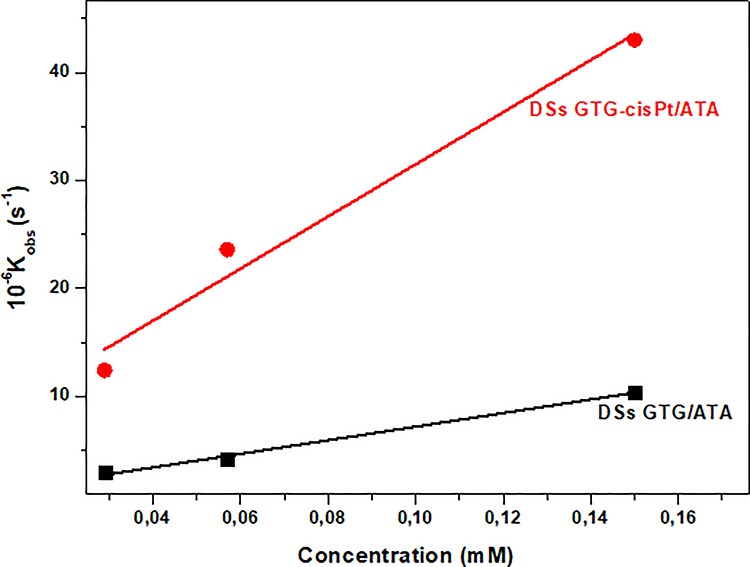
Pseudo-first-order rate constant kobs vs DSs GTG-cisPt/ATA and DSs GTG/ATA.